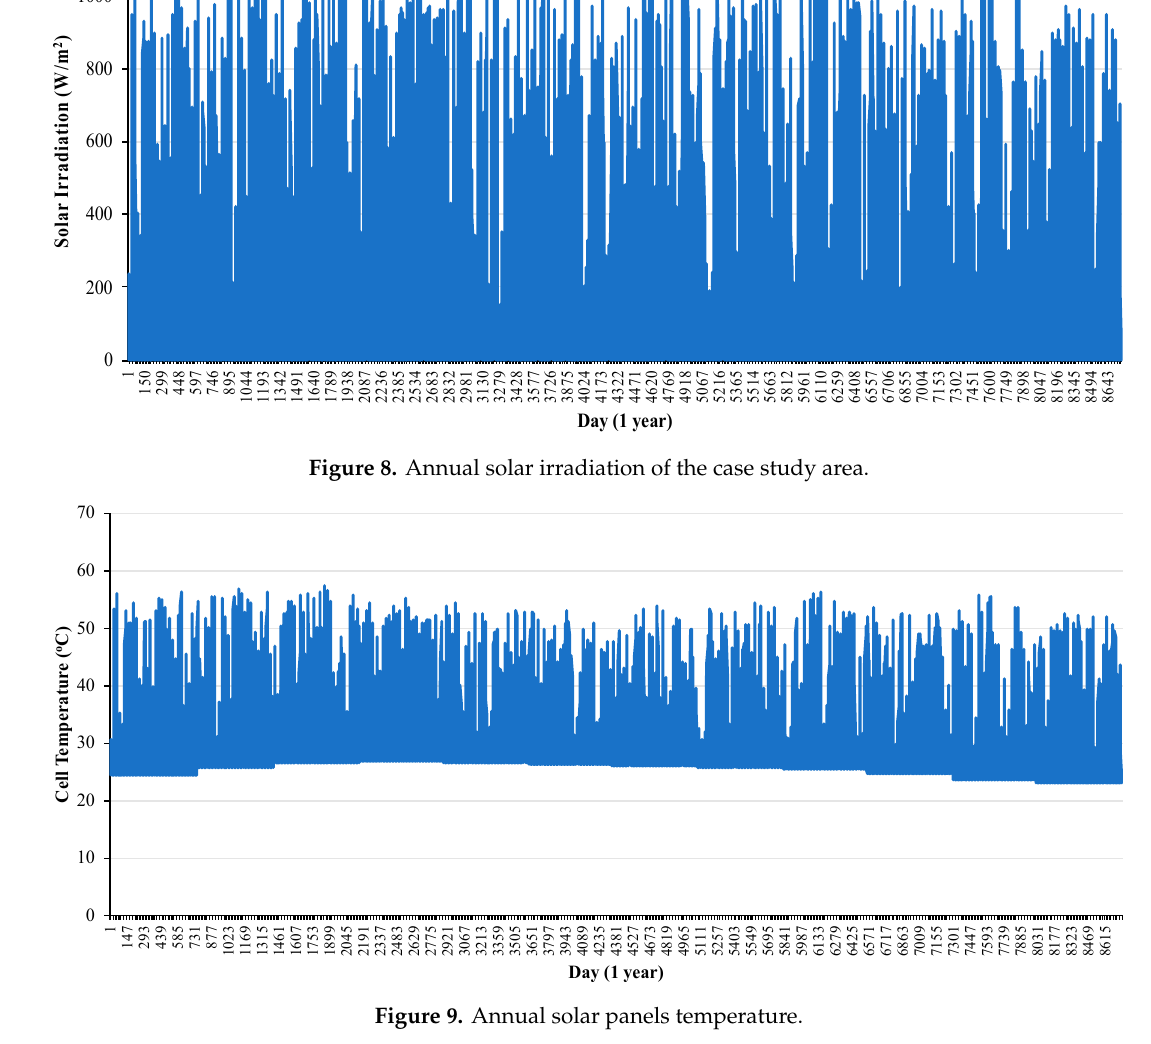
Figure 10. PV power output and solar irradiance. 5. Simulation Results and Discussion A MATLAB program is used to simulate the PV power output forecasting by inputting one year of input data, which is the actual measured power output, solar irradiation, panel temperature, and ambient temperature. The PSO-ANN technique is used to simulate the calculation cycle of 100 cycles, the population of 100 population, and the number of neurons of 10 cells. The annual power output forecasts are shown in Figure 11, in which some of the predicted electrical power is less than zero because it is a random method. It has a maximum error of 1721 kW, as shown in Figure 12. In April it is the month in which the most energy was produced from solar energy and it is summer in Thailand, which has the most solar radiation intensity. Therefore, the forecasting results of April 1–7 were selected. Figure 13 shows a weekly PV power output forecasting with PSO-ANN. Figure 14 shows a